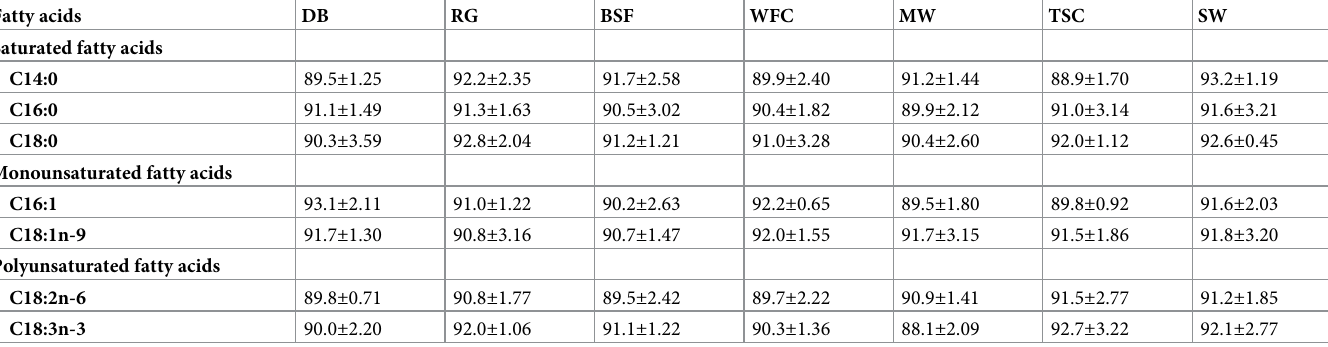
Table 7. Apparent digestibility coefficients (ADCs, %) of fatty acids in the tested insect meals for Pacific white shrimp ( Litopenaeus vannamei ). Fatty acids DB RG BSF WFC MW TSC SW Saturated fatty acids